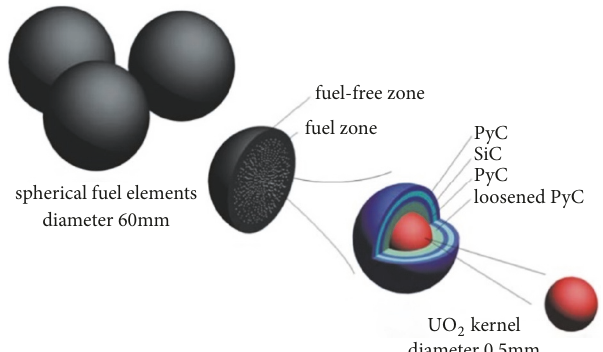
Figure 3: The spherical fuel element of